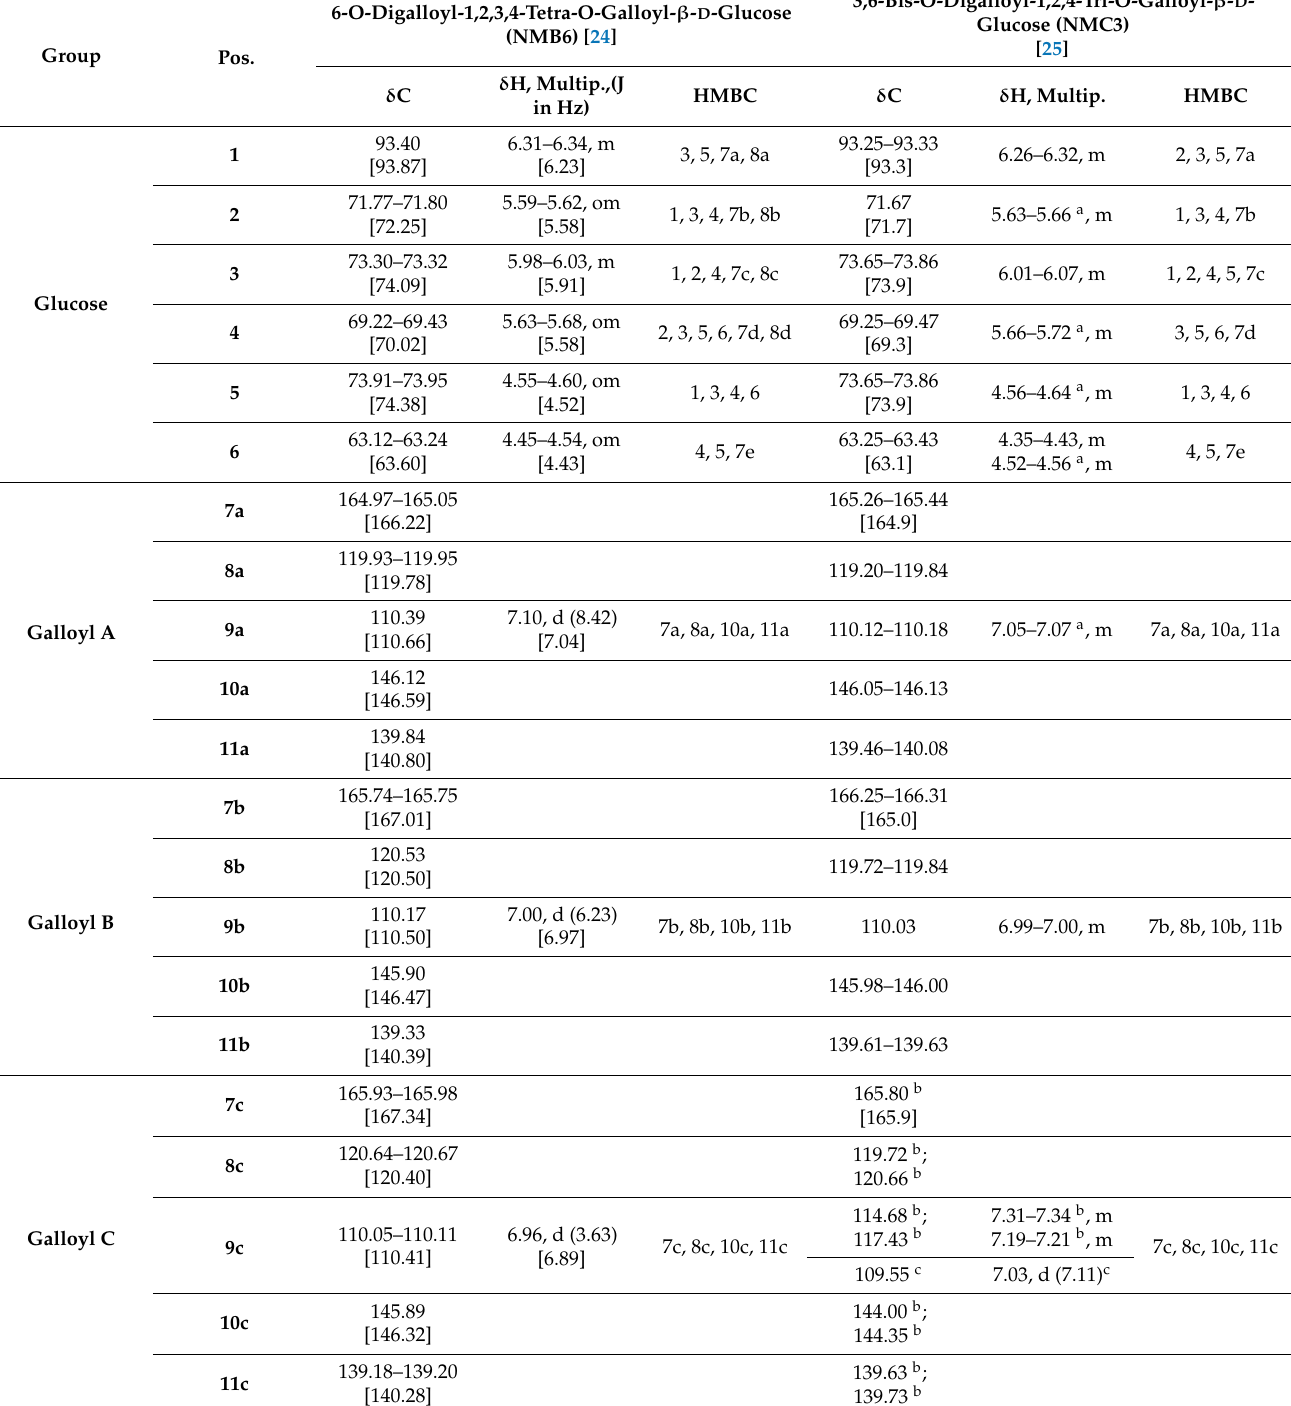
Table 2. 1 H and 13 C chemical shifts and HMBC correlations for compounds NMB6 and NMC3 (600 MHz). Chemical shifts of the same compounds previously reported in the literature are shown in square